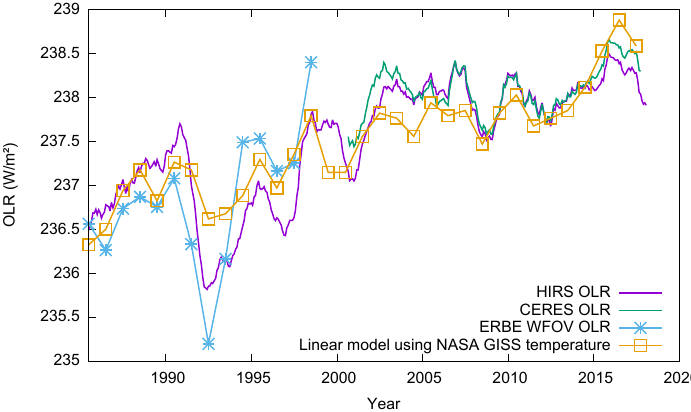
Figure 4. Purple curve: HIRS OLR. Green curve: CERES OLR. Blue curve: ERBE WFOV OLR. Orange curve: linear regression model based on NASA GISS T anomaly.